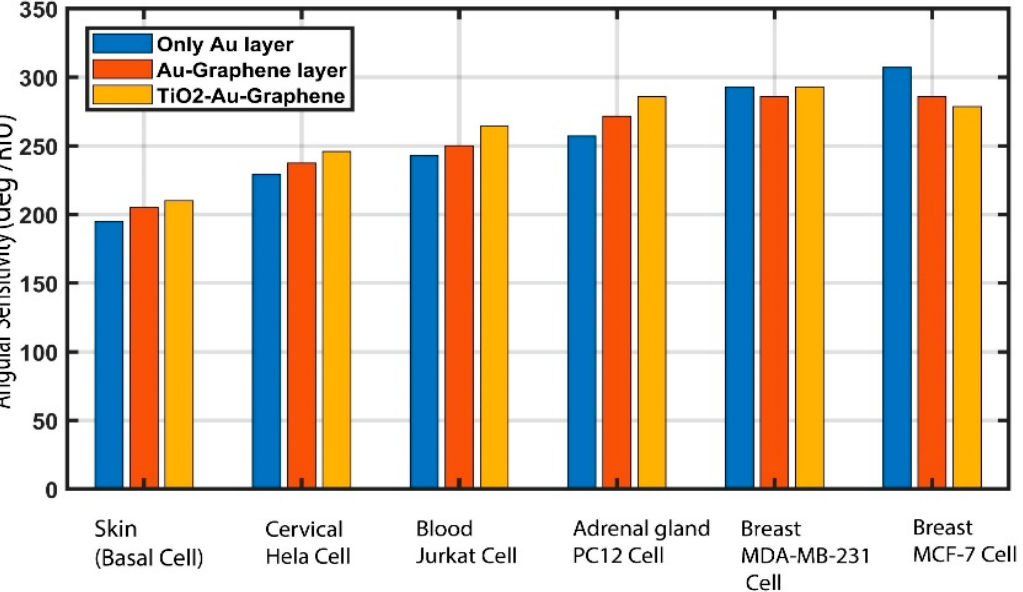
Figure 7. Influence of material layers on angular sensitivity for the following structures: (i) BK 7 /Au/analyte; (ii) BK 7 /Au/graphene/analyte; and the proposed (iii) BK 7 /TiO 2 /Au/Graphene/analyte on the angular sensitivity for various types of cancer detection. Table 3. Impact of material layers on the sensitivity of various types of cancer.